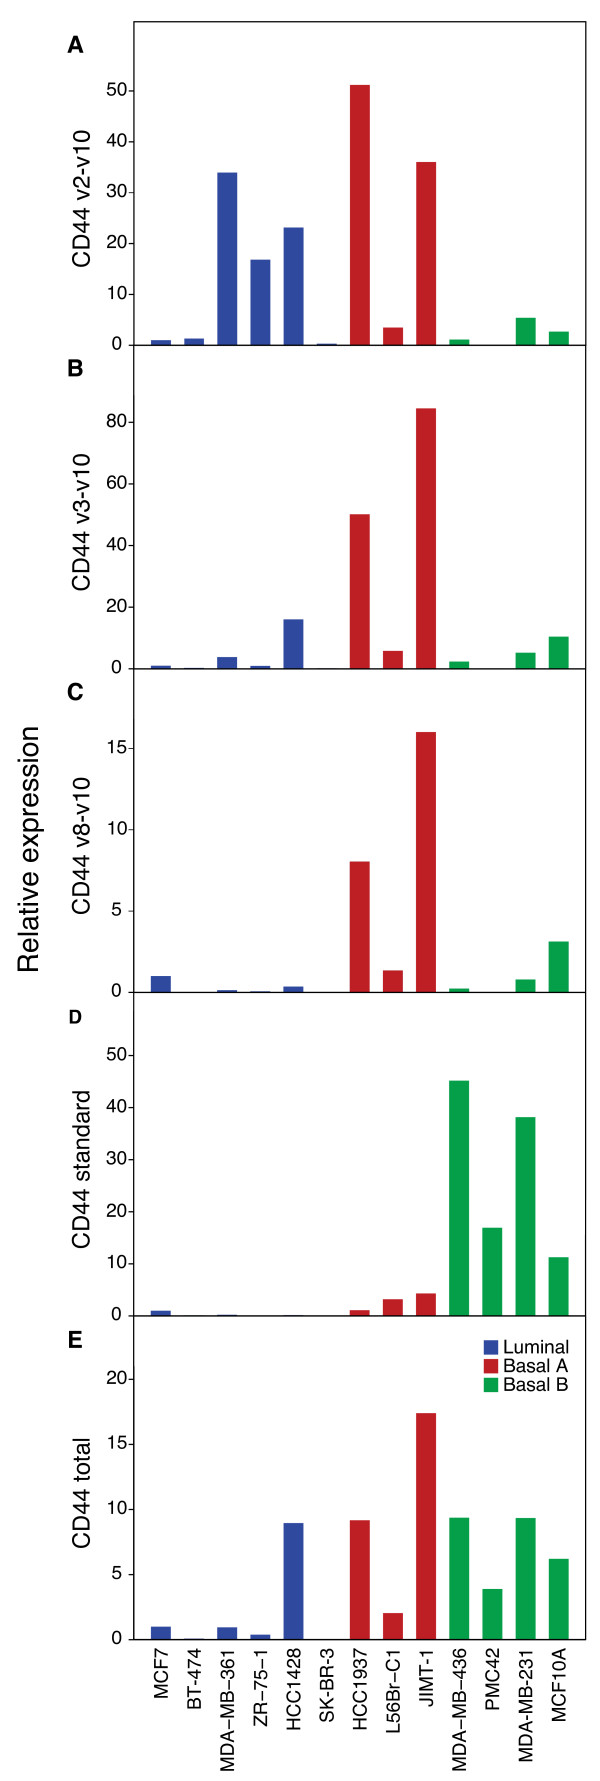
CD44 splice variants show heterogeneous expression patterns in breast cell lines. A to E. Q-RT-PCR analyses (on mRNA level) of the splice variants CD44v2-v10, CD44v3-v10, CD44v8-v10 and CD44S in breast cell lines of different molecular subtypes. The expression of CD44S was generally high in the basal B cell lines whereas the other isoforms were predominately expressed in the basal A cell lines.